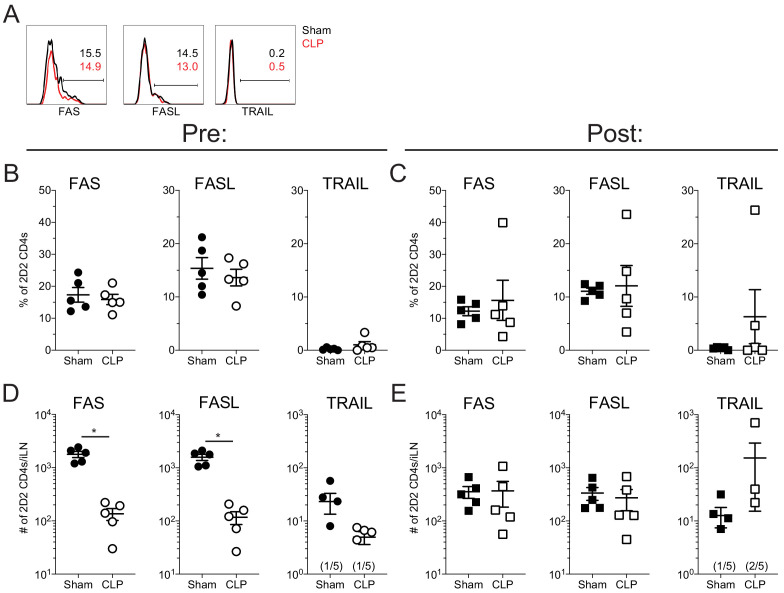
Sepsis does not influence the expression of Fas, FasL, and TRAIL by autoantigen-specific T cells.Thy1.2 C57Bl/6 mice were separated into Pre- and Post-transfer groups. The Pre-transfer group received 5 × 103 naive Thy1.1 2D2 TCR-Tg CD4 T cells 1 day before sham or CLP surgery. The Post-transfer group underwent sham or CLP surgery then received 5 × 103 naive Thy1.1 2D2 TCR-Tg CD4 T cells 4 days later. EAE was induced in both the Pre- and Post-transfer groups 5 days after surgery (Pre: 6 days post 2D2 T cell transfer; Post: 1 day post 2D2 T cell transfer). iLN were harvested 7 days after the transfer. (A) Representative gating of Fas, FasL, and TRAIL expression by 2D2 CD4s. Frequency (B) and number (C) of Fas, FasL, and TRAIL expressing cells in the pre-transfer group. Frequency (D) and number (E) of Fas, FasL, and TRAIL expressing cells in the post-transfer group. Data are from 1 experiment with five mice per group. *p<0.05. Error bars represent the standard error of the mean.
Figure 6—figure supplement 1—source data 1.Source data for Figure 6—figure supplement 1.